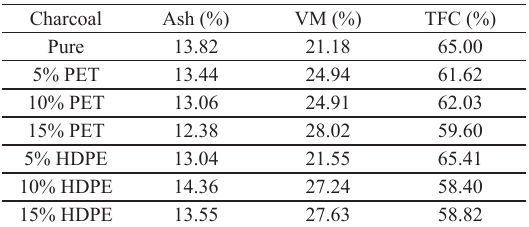
Table 1. Ash, volatile matter (VM), total fixed carbon (TFC) of pure charcoal and blends.